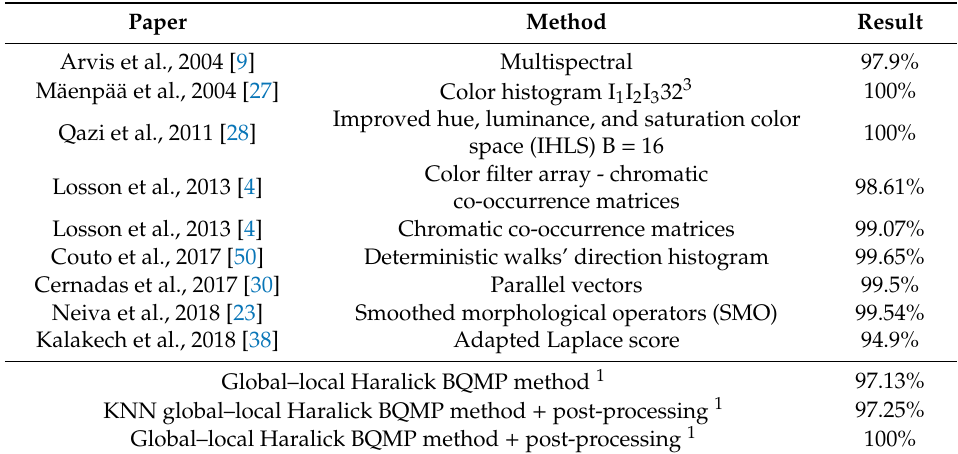
Table 4. Best results of global–local Haralick–BQMP classification for the Vistex database with 54 images and best results published previously on the same